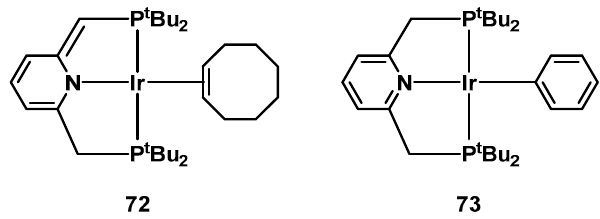
Figure 5. Iridium-based complexes 72 and 73 synthetized by Milstein [619].